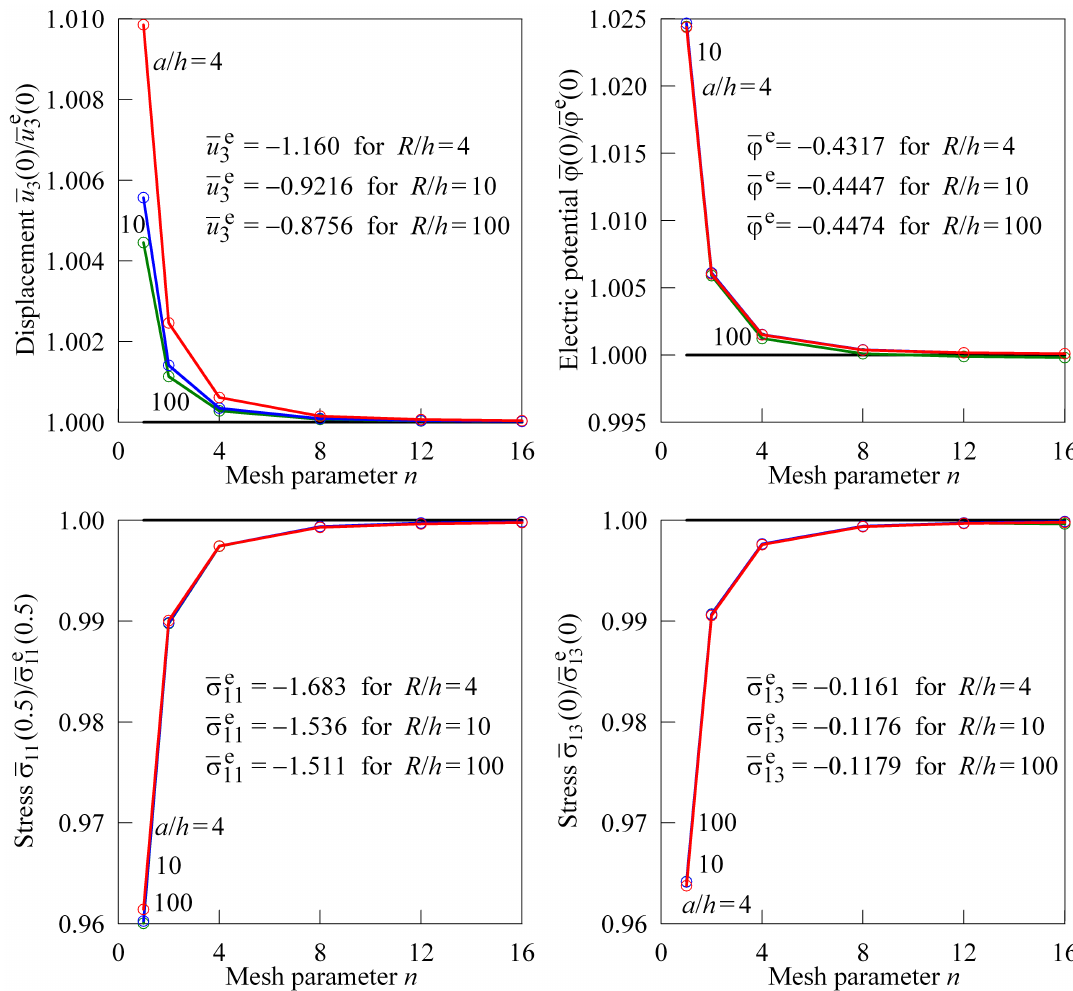
Figure 5: Convergence study due to mesh refinement for a FGM piezoceramic square plate with α = 1 and N = 7 using uniform 4 n × 4 n meshes with n = 1, 2, 4, 8, 12 and 16 ; reference values are provided by the exact SaS solution [47] taking seven SaS.